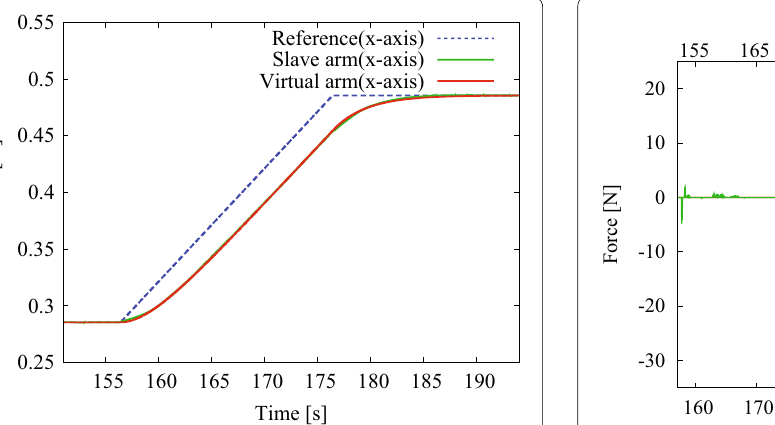
Fig. 13 Position of slave arm and virtual arm (x-axis) (in HILS 1)